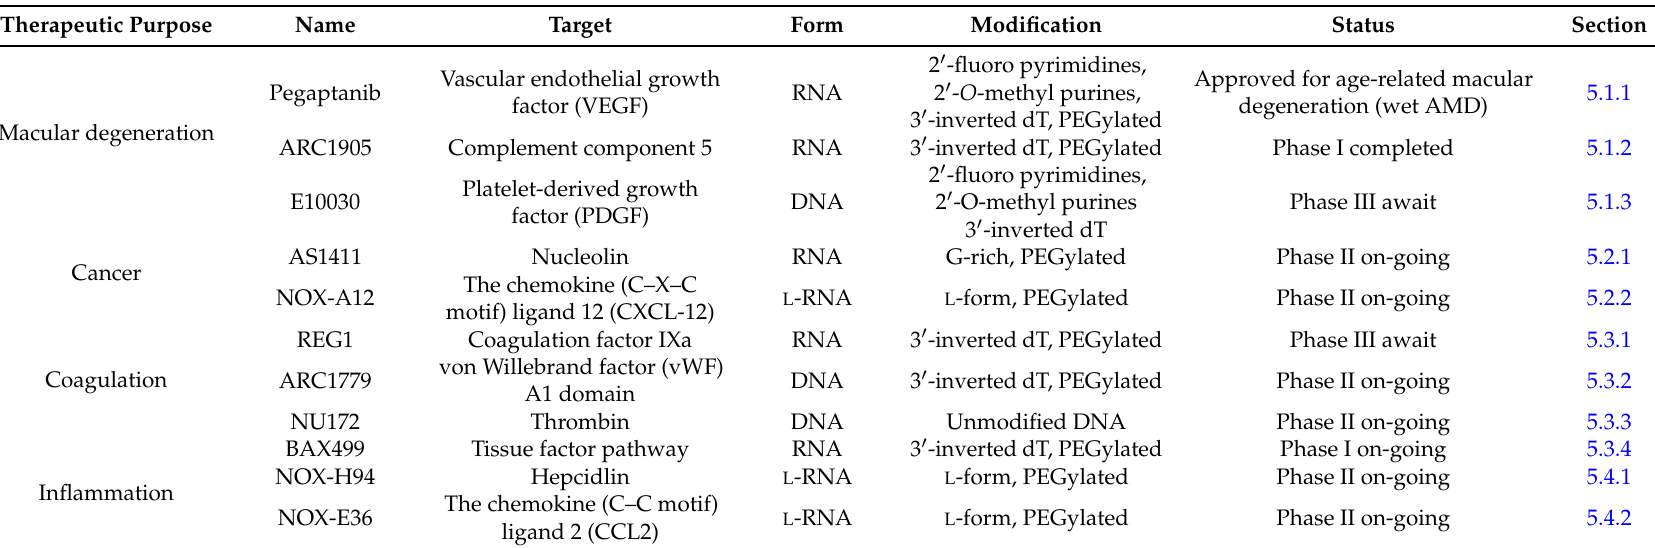
Table 2. Progress of aptamers for diseases therapy in on-going or completed clinical trials